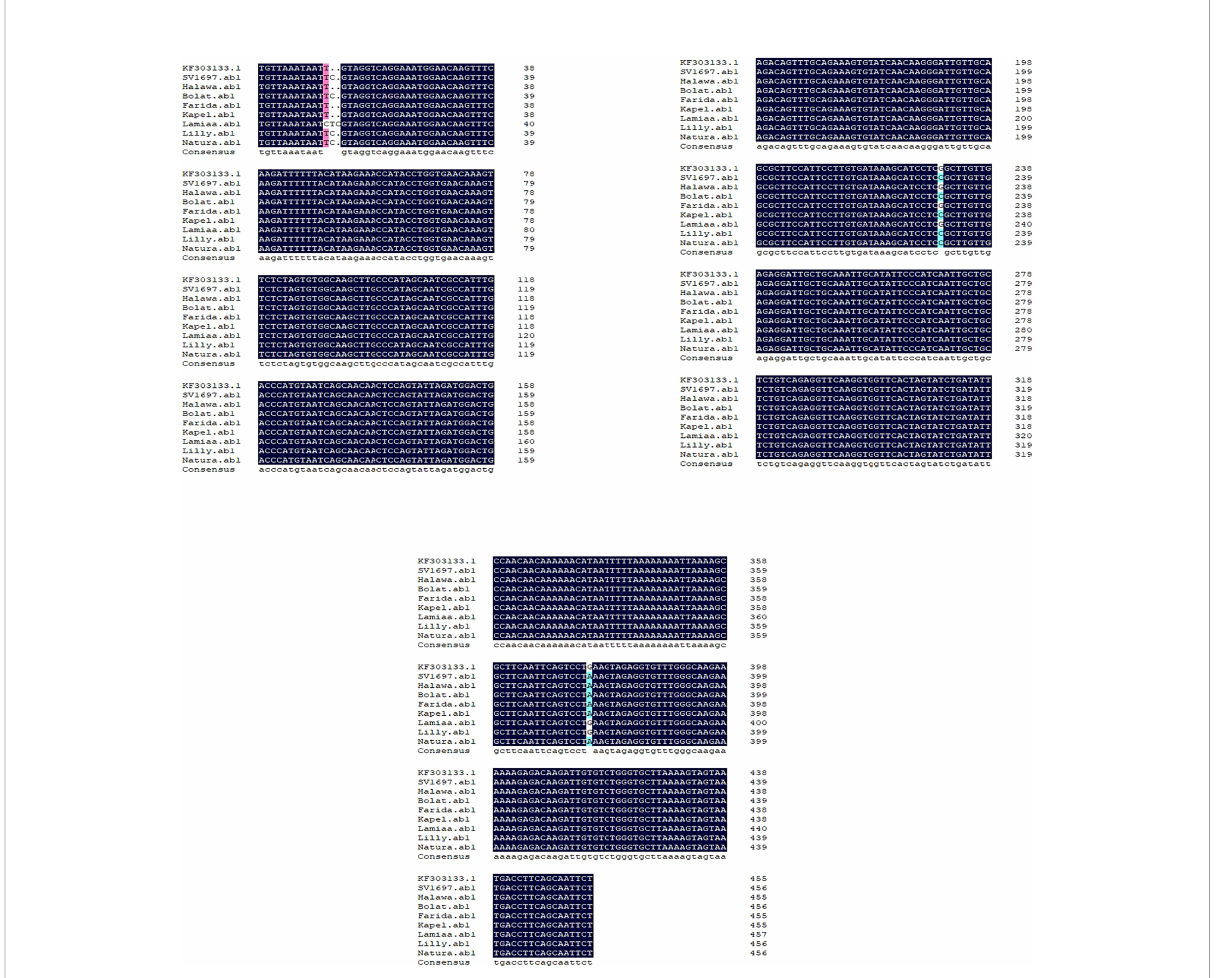
FIGURE 7 Single nucleotide polymorphisms (SNPs) detection for Anchor KF303133.1 and eight sugar beet genotypes sequences by using the DNAMAN ® software (Lyon BioSoft, Quebec, Canada). Gaps in the sequences are indicated by dots ‘‘ . ’’ , showing the conserved consensus sequences at the last sequence. SNPs are indicated by different shading colors.